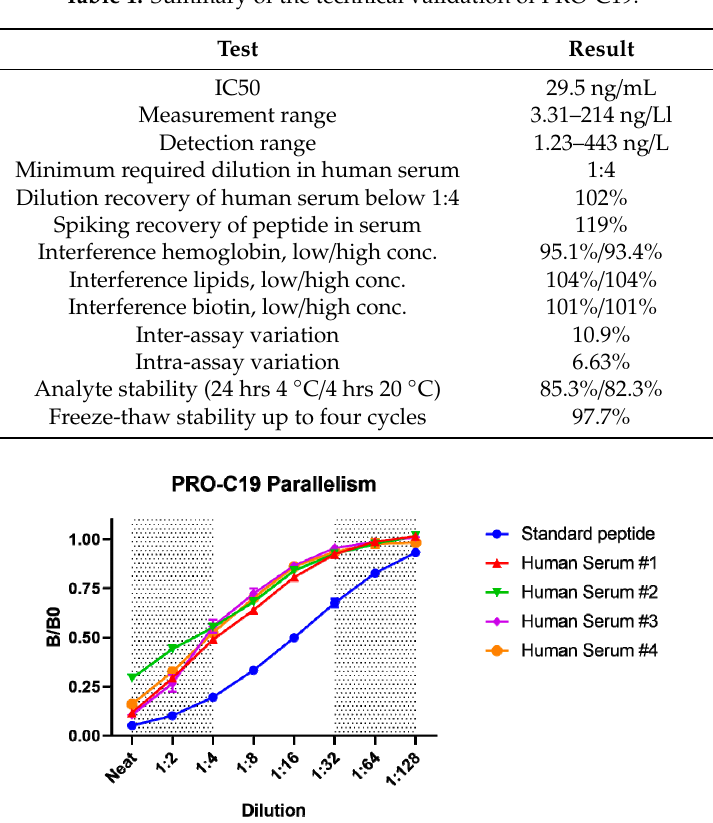
Figure 1. PRO-C19 assay specificity. Inhibition curve for the standard peptide (SHAHQRTGGN), elongated peptide (SHAHQRTGGNA), truncated peptide (SHAHQRTGG) as well as non-sense standard peptide (GVAPGIGPGG) and a non-sense coater peptide (Biotin-GVAPGIGPGG). Peptides were diluted twofold in series to evaluate their propensity to compete for antibody binding. Signal is shown as a fraction of the background absorbance (B0), corresponding to assay buffer, as a function of the peptide concentration on a logarithmic scale. Error bars indicate standard deviation from duplicate measurements. Table 1. Summary of the technical validation of PRO-C19.